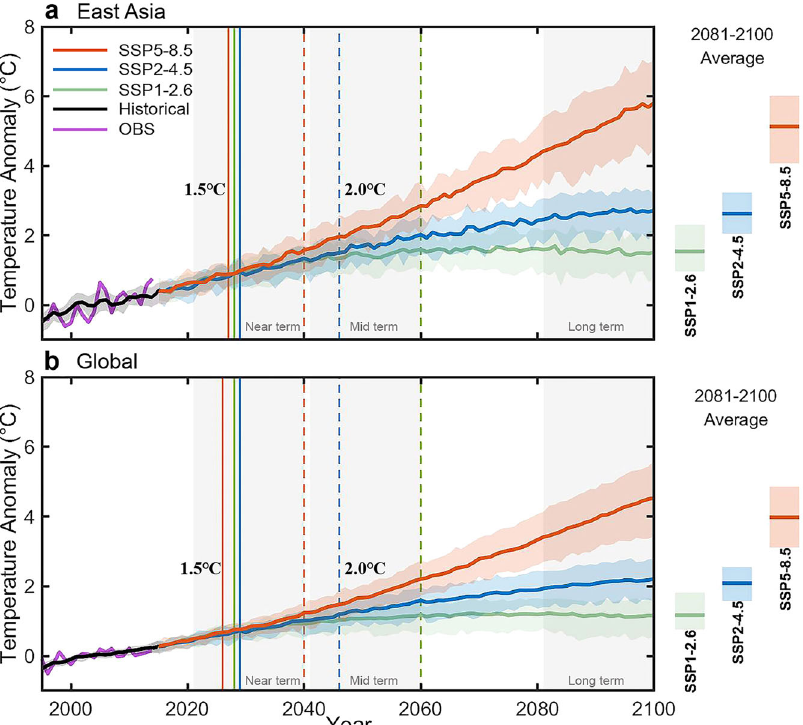
Fig. 1 Projections of temperature change (°C) relative to the reference period 1995 – 2014 for observations (ERA5 reanalysis) (purple), historical (black), SSP1 – 2.6 (green), SSP2 – 4.5 (blue) and SSP5 – 8.5 (red) scenarios. a For the East Asia and b for the global. For each scenario, the median (solid lines) and the 17 – 83% likely range (shading) are shown. The bar plots on the right side of each panel represent the median (solid lines) and 17 – 83% likely range of the projections averaged over 2081 – 2100. Vertical lines at GW1.5/2 represent the time when